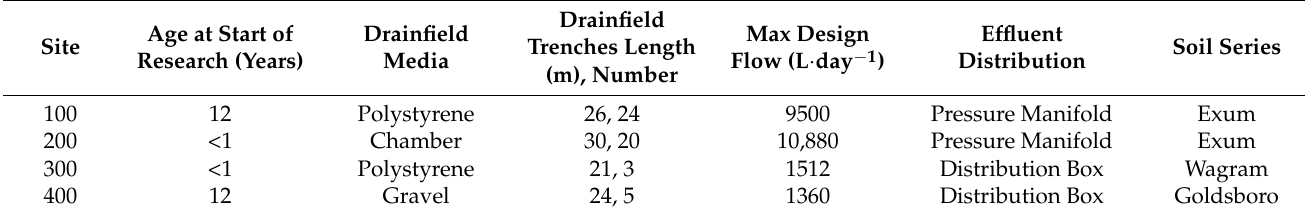
Table 1. System and soil characteristics for Sites 100 to